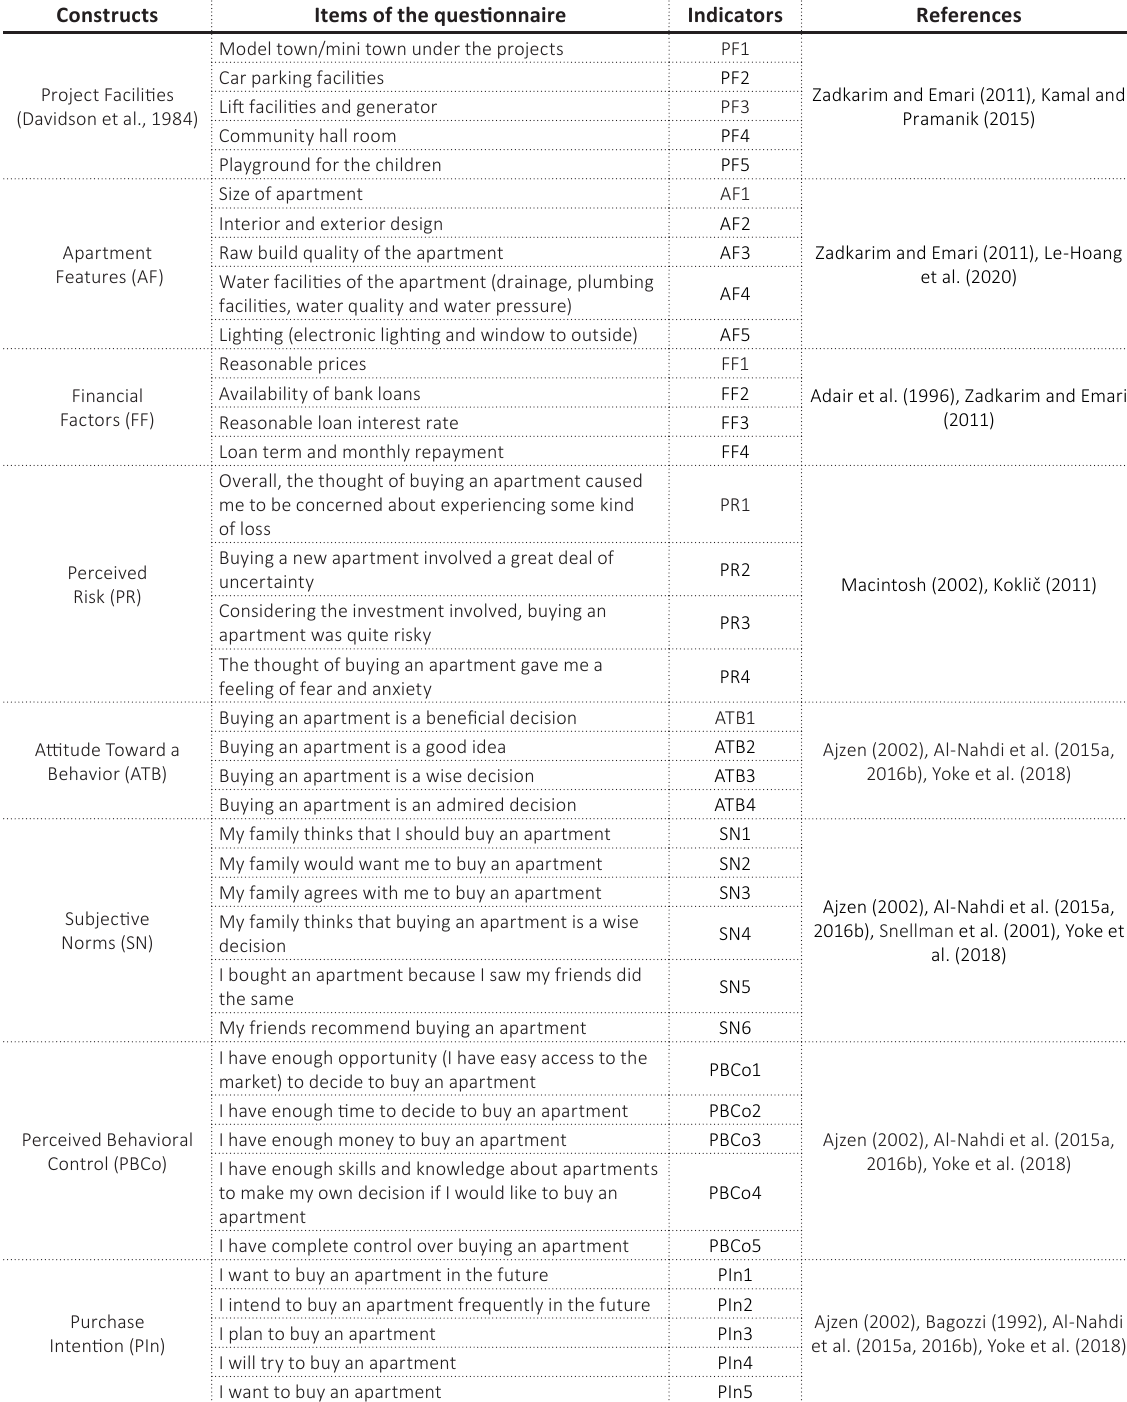
Table A1. Measuring scales and references for the proposed